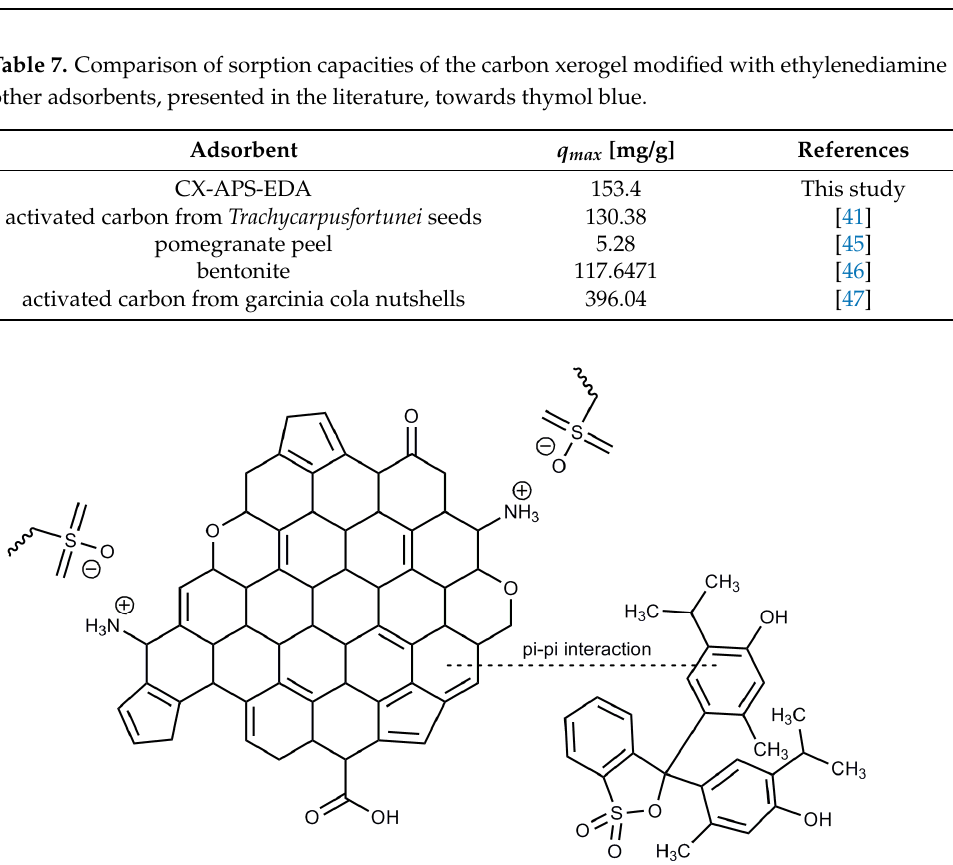
Table 7. Comparison of sorption capacities of the carbon xerogel modified with ethylenediamine to other adsorbents, presented in the literature, towards thymol blue.